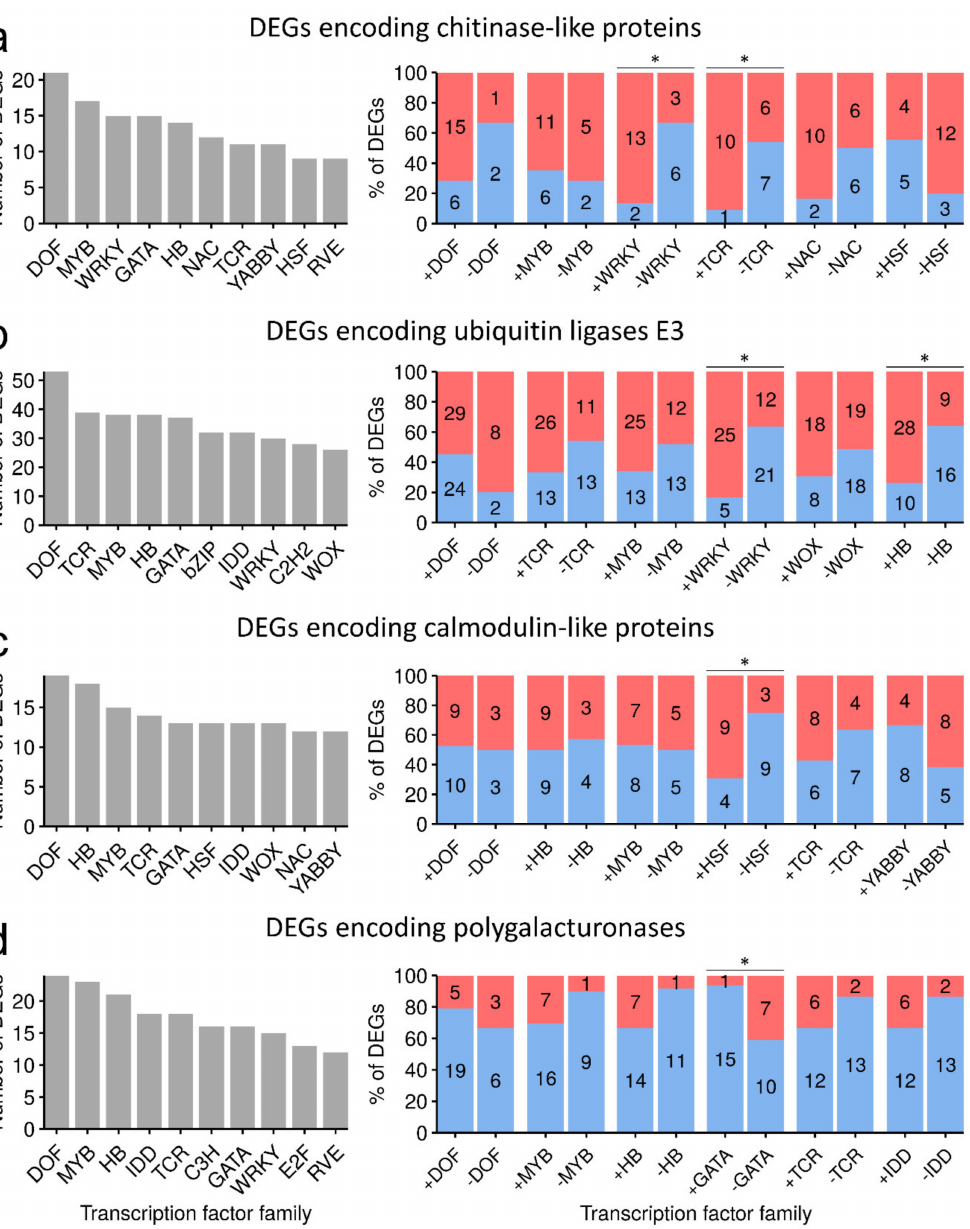
Figure 8. The e ff ect of cis-regulatory elements (CREs) related to di ff erent transcription factors in the promoter regions of genes encoding chitinase-like proteins ( a ), ubiquitin E3 ligases ( b ), calmodulin-like proteins ( c ), and polygalacturonases ( d ) on their expression pattern. Left-hand side panels: the total number of DEGs with CREs attributed to the TF families denoted on the X-axis (the top 10 TF families are presented). Right-hand side diagrams: the proportions of up- (red) and down- (blue) regulated DEGs (%) depending on the presence ( + TF) or absence (-TF) of CREs for a certain TF family. The numbers in the columns show the absolute number of DEGs in each category. Data for six groups of TFs are presented: the first three pairs of columns are for the top three TF families from the left bar chart; and the next three pairs of columns are for those TF families for which the di ff erences in the ratios of up / downregulated target DEGs and the ratios of up / downregulated non-target DEGs are the highest. Asterisks (*) show the significance of the di ff erence ( p < 0.05) in the ratios of up / downregulated genes between the groups of DEGs with and without CREs for TFs of a certain family. The significance was determined using Fisher’s exact